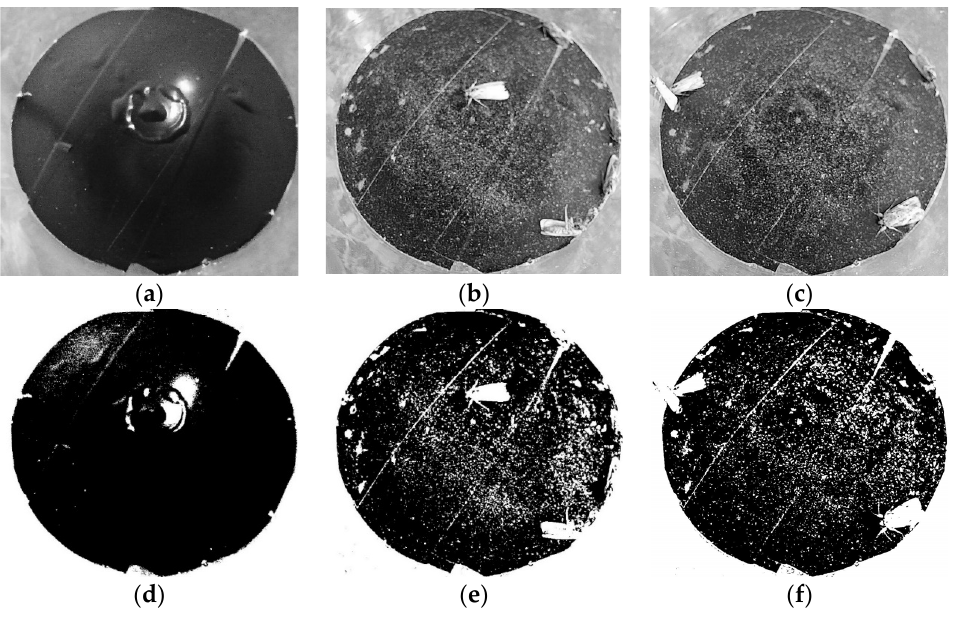
Figure 9. Image preprocessing. ( a ) Background grayscale image. ( b ) S. frugiperda grayscale image with light spot. ( c ) Grayscale image with S. frugiperda at the bo tt om edge of bucket. ( d ) Background binarization image. ( e ) S. frugiperda binarization image. ( f ) Binarization image with S. frugiperda at the bo tt om edge of bucket.